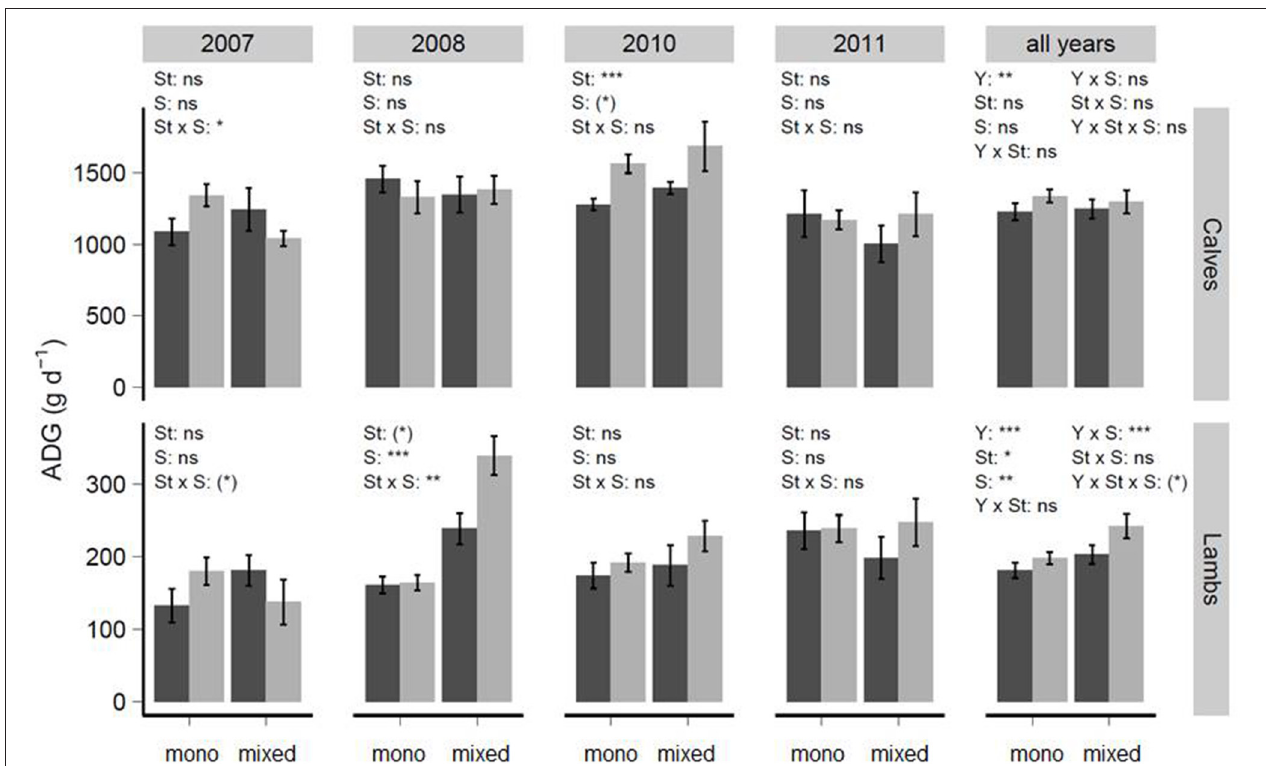
FIGURE 3 | Animals’ average daily gains (animal-ADG, g d − 1 ) of calves and lambs (means ± se) in relation to year, sward type (St) and grazing system (S, mono- or mixed-grazing). The dark gray bars highlight grass-dominated swards, while light gray bars show diverse-swards. In statistical analyses of lamb animal-ADGs, the varIdent-structure was used to model heterogeneous variances within treatments (2008), grazing cycles and sward type (2010) or years (all years-model). ns, not significant, * P < 0.1, * P < 0.05, ** P < 0.01, *** P <